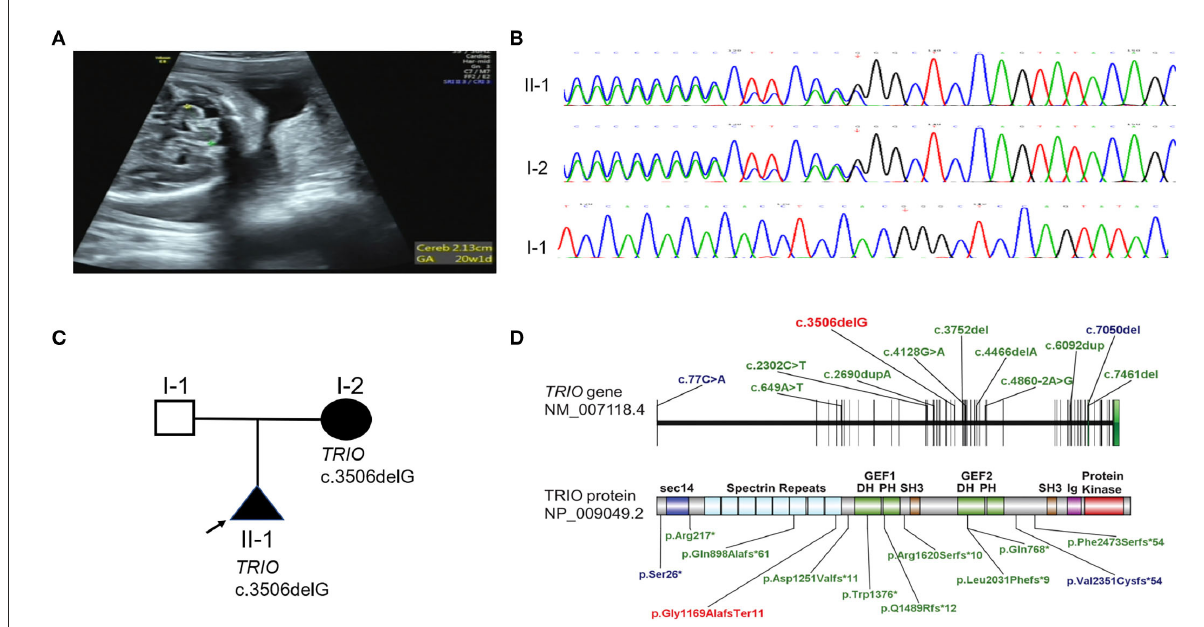
FIGURE1 Phenotype and gene variation in TRIO cases. (A) Delayed development of cerebellar (equivalent to 20 weeks) of case 1 in 25 weeks of pregnancy was detected by prenatal ultrasound. (B) TRIO c.3506delG variation in case 1 and case 2 were confirmed by Sanger sequencing. (C) Family pedigree of TRIO variation cases. (D) Schematic representation of TRIO domains and LOF variations identified in affected individuals (blue: macrocephaly; green: microcephaly; red: variant found by us).